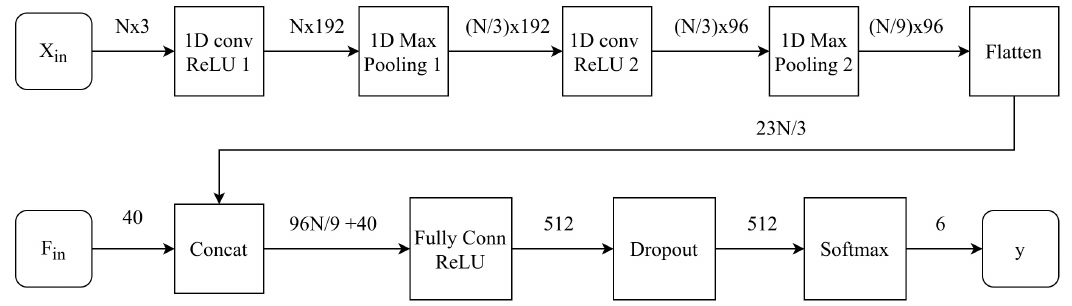
Figure 1. Detailed network